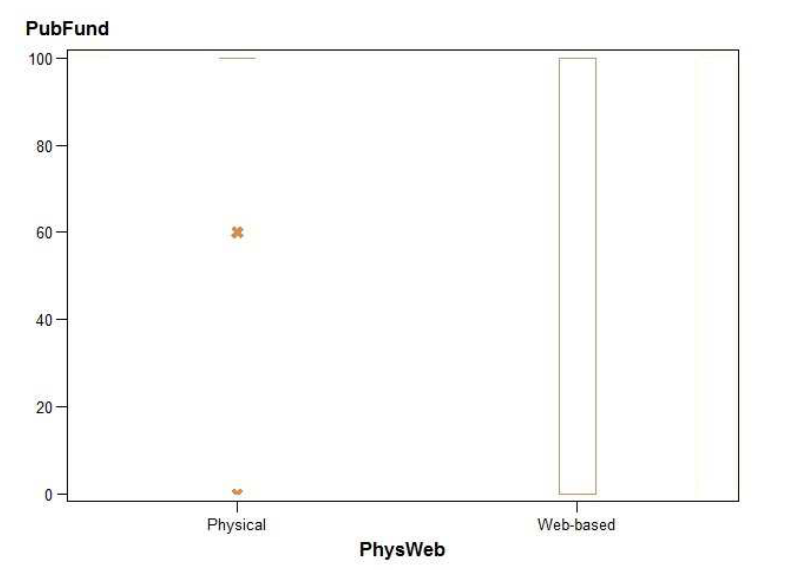
Figure 1 – Box-plot of percentage of public funding in Physical and Web-based